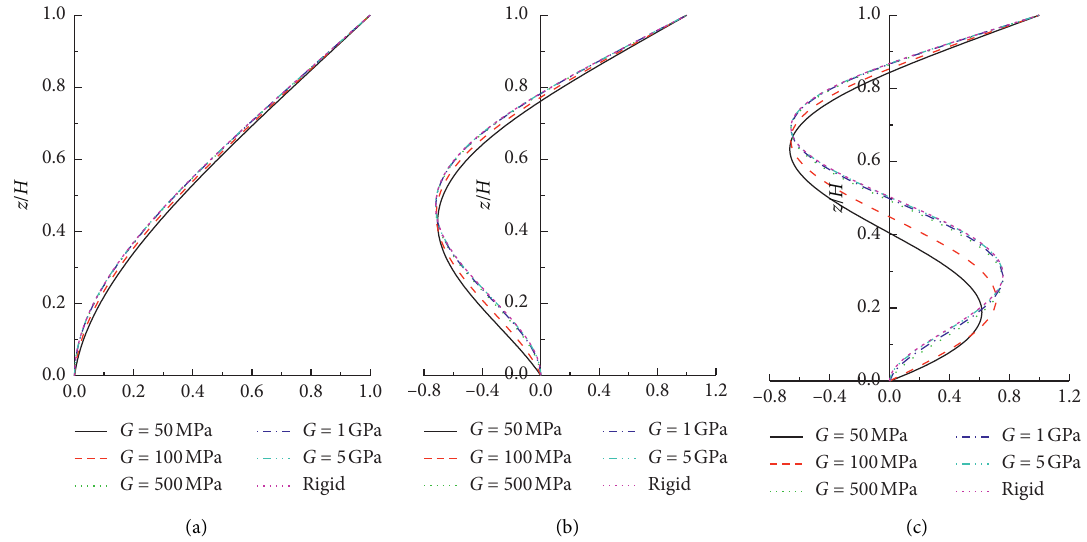
Figure 13: Vibration mode shapes in a vacuum for different values of G with H � 8m, l third.